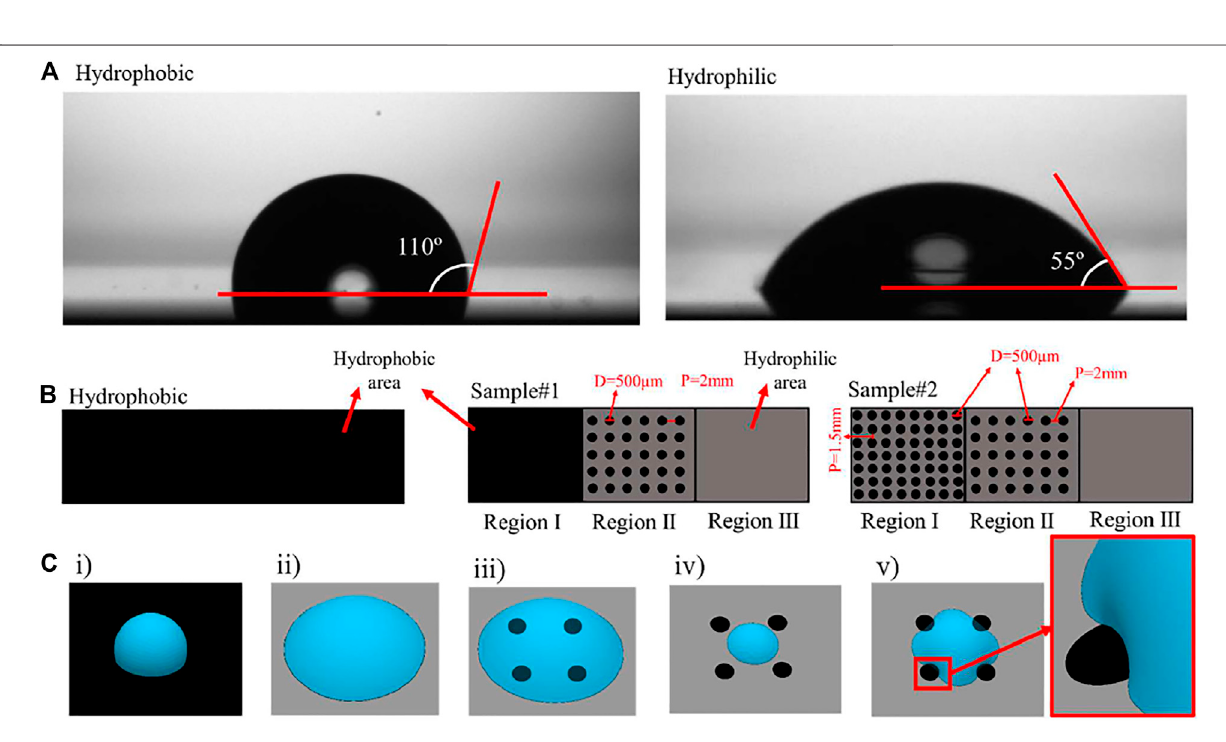
Frontiers in Mechanical Engineering |